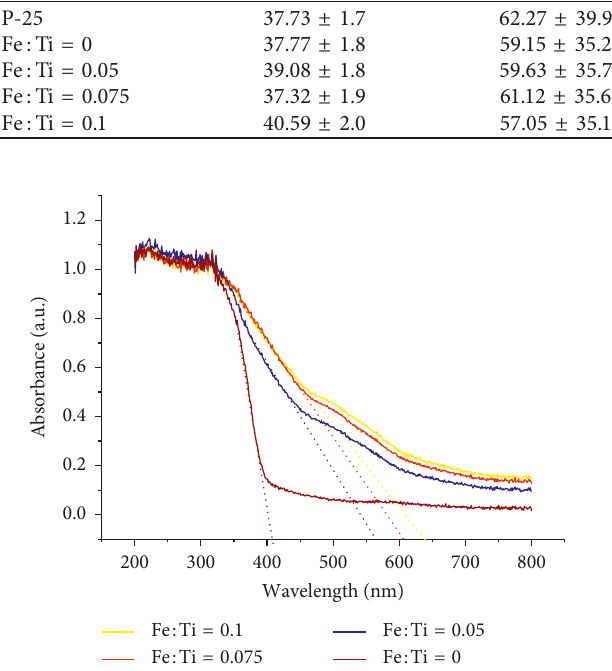
Table 3: Atomic percentages and doping impregnation efficiency obtained EDS analysis.